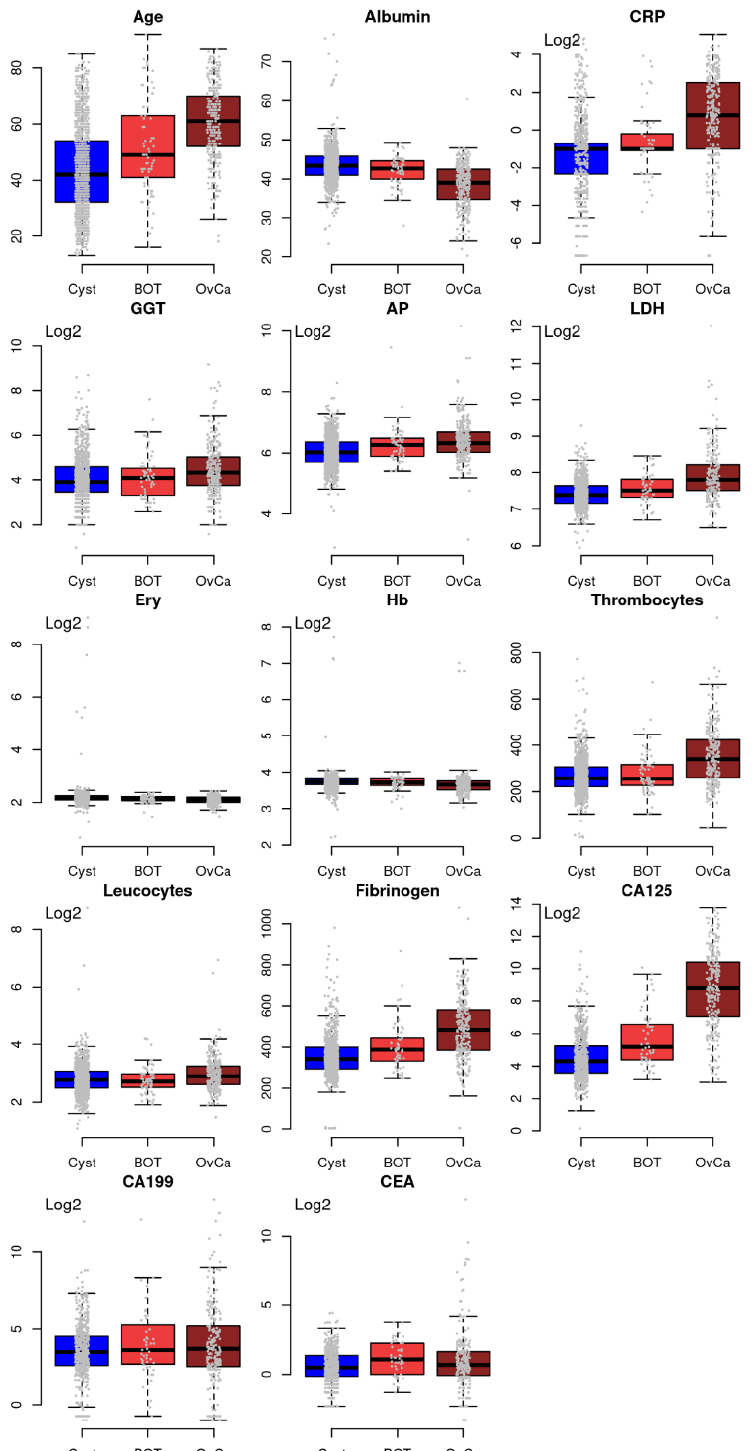
Figure 6. Characteristics of the single predictors compared between benign, BTO, and EOC. Y -axis: values are linear of log2 transformed, as indicated by the word “Log2”. Units of analytes are as provided in Table